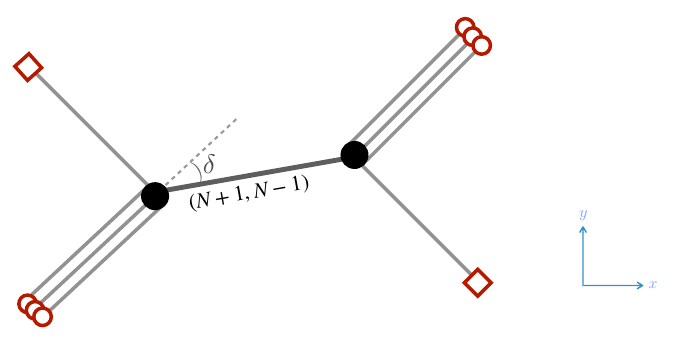
Figure 10 . Opening the fixed point via a supersymmetric deformation with parameters t i = − 2 m i = h . The (1 , − 1) 5-branes remain at a 90 degrees angle with the (1 , 1) 5-brane stack,